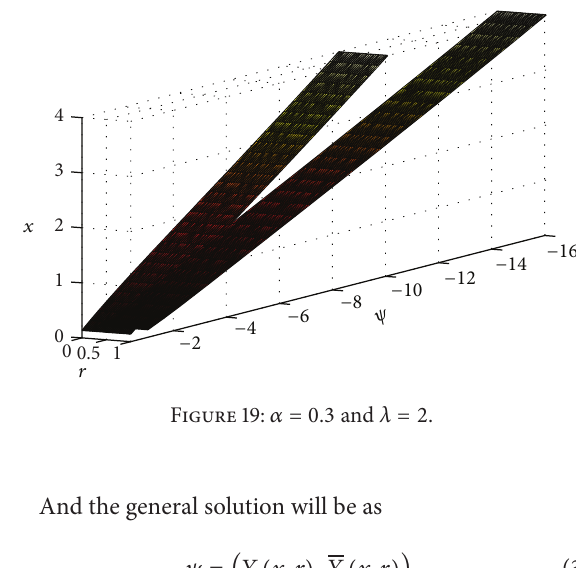
Figure 18: 𝛼 = 0.8 and 𝜆 = 2 .